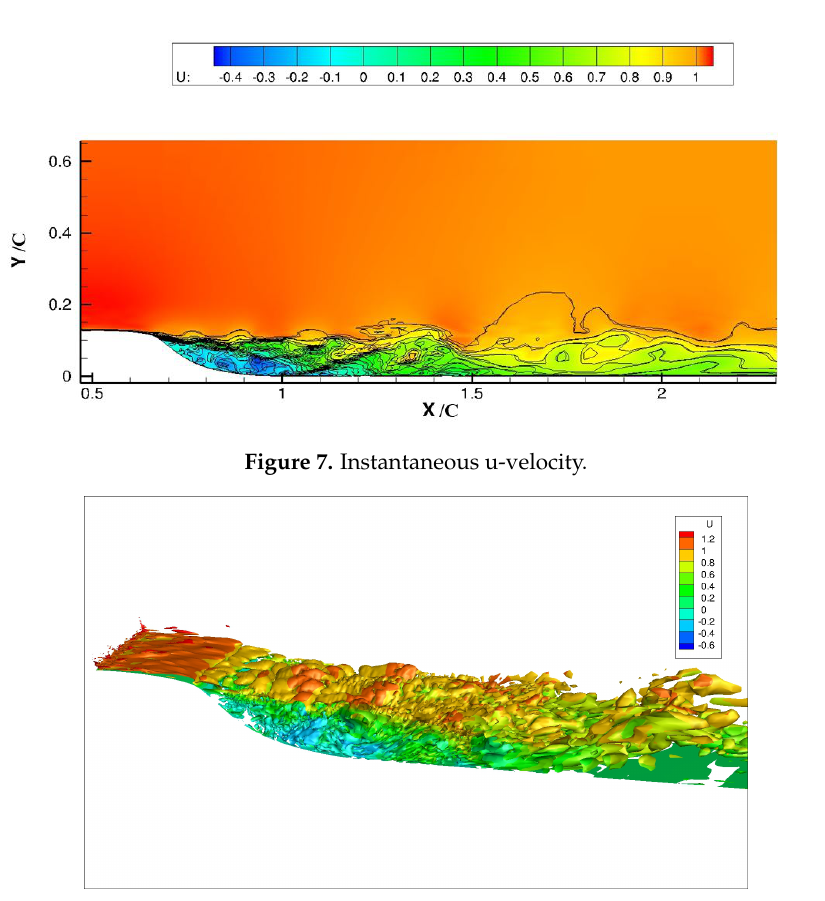
Figure 8. Instantaneous iso-surface of Q = 150 showing complex flow structures.